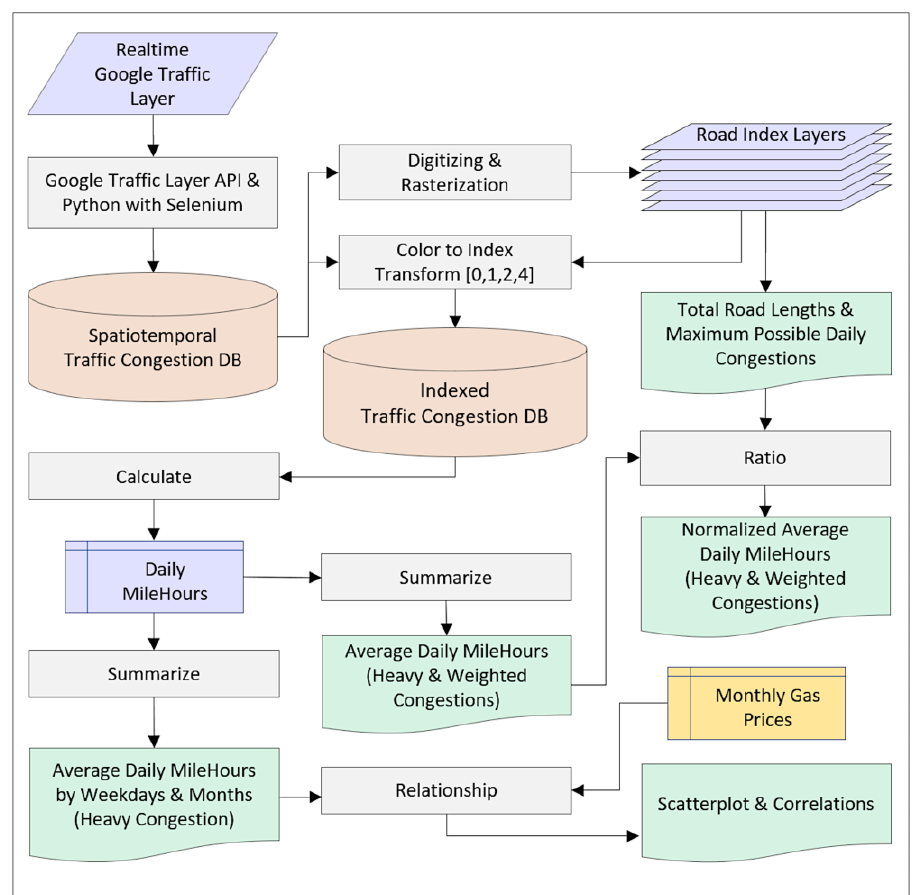
Figure 3. Workflow of data processing and analyses.